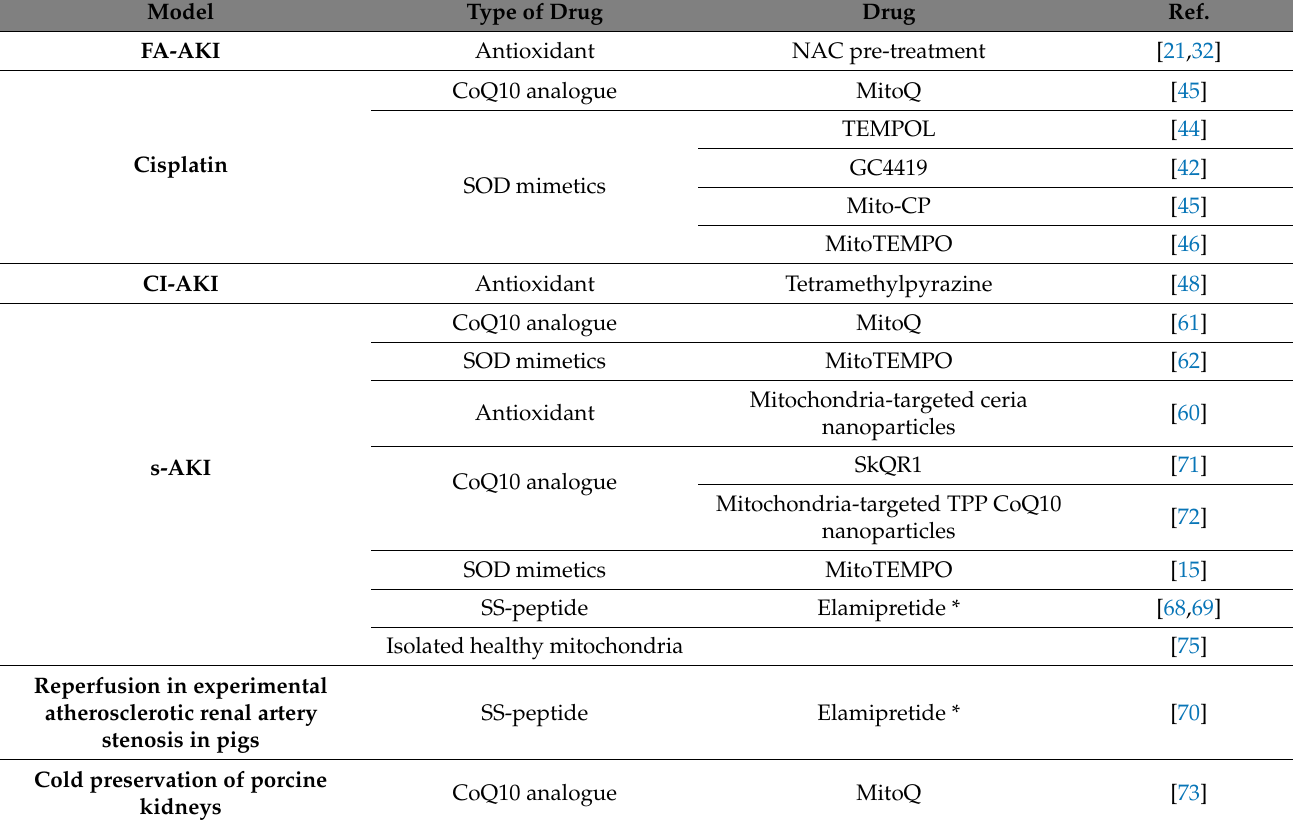
Table 1. Drugs targeting mitochondrial ROS that have shown beneficial effect in experimental